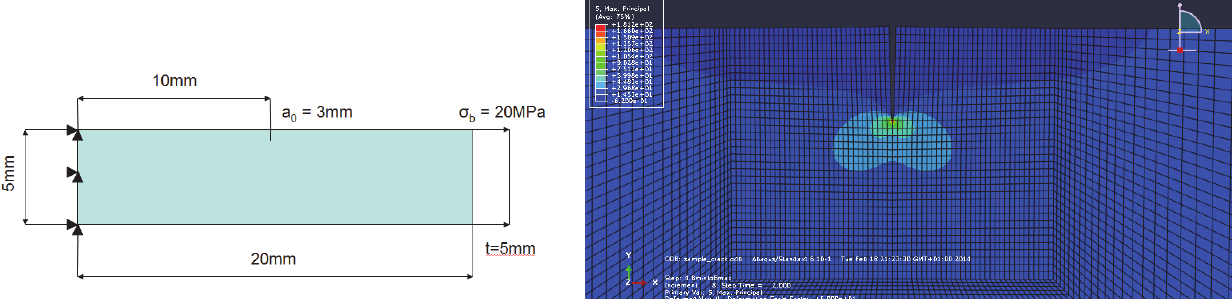
Figure 3: Left, geometry and loads of the model of a cracked bar in tension. Right, detailed view of a von Mises contour plot.